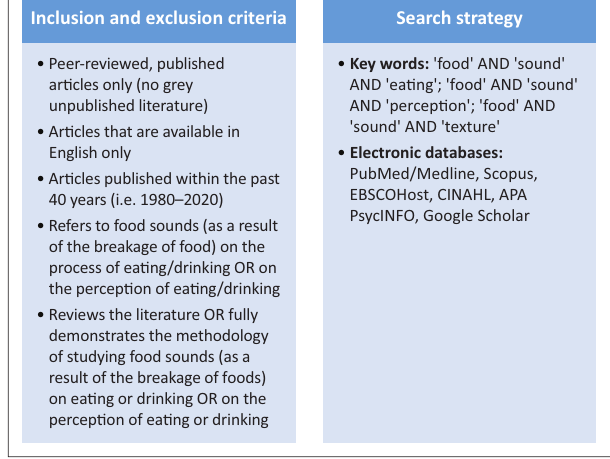
FIGURE 1: Parameters of the revised scoping